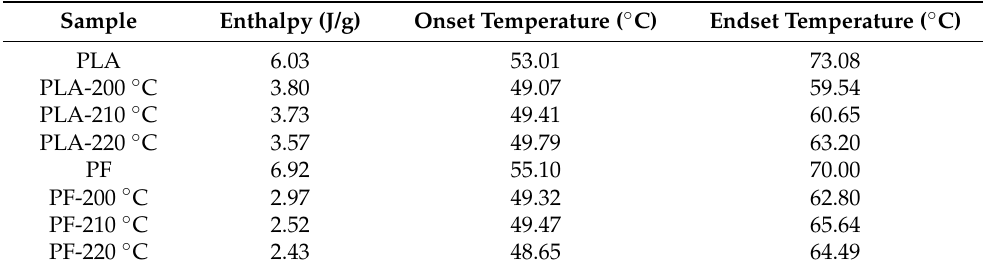
Figure 6. Heat flow (HF) of ( a ) PLA and ( b ) PF for different printing temperatures (200 °C, 210 °C, and 220 °C). Table 4. Enthalpies and characteristic temperatures of the glass transition of PLA and PF for the as- received PLA and PF filaments and extruded ones at three printing temperatures (200 °C, 210 °C, and 220 °C) namely under the nomenclature PLA and PF followed by the printing temperature.